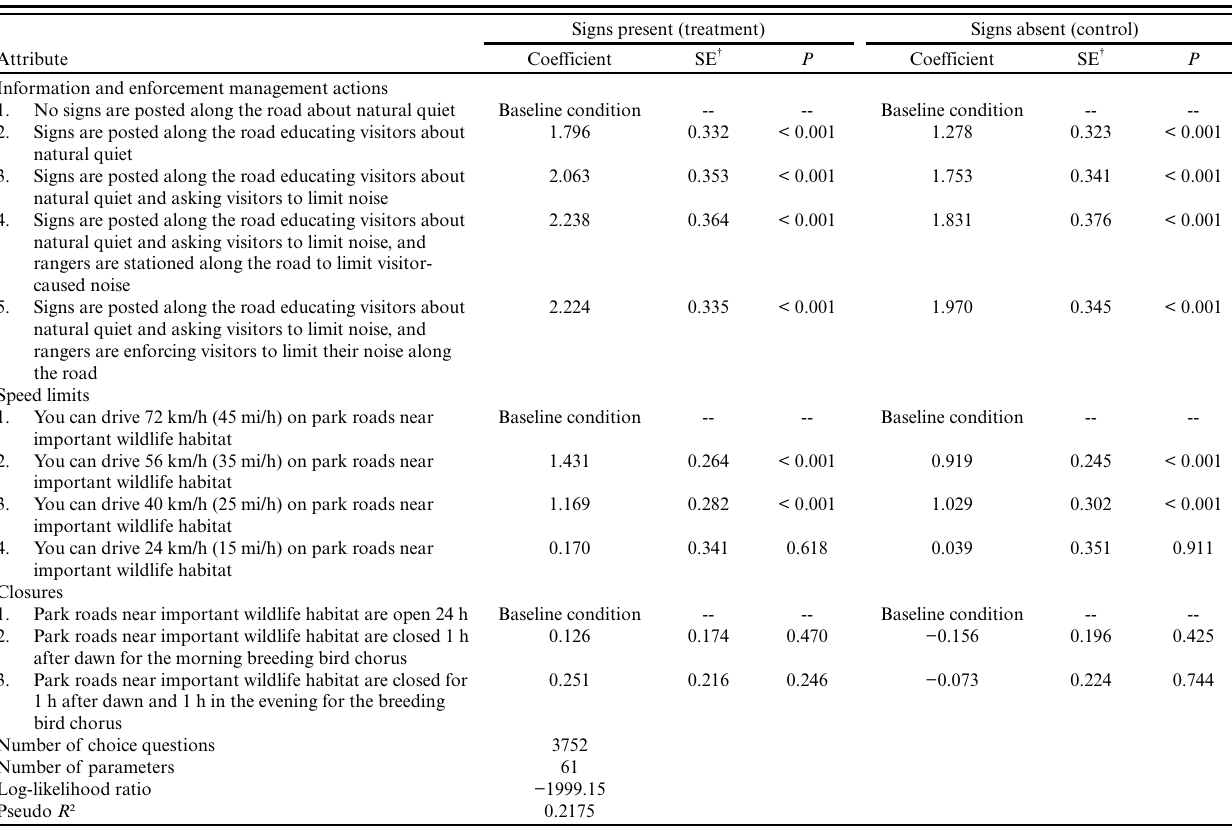
Table 2. Results from the stated choice model for visitor preferences for soundscape management for sign-absent and sign-present conditions. All parameters are assumed to be normally distributed, while correlations are allowed only within levels of each attribute. The model was normalized by preference for bird song.